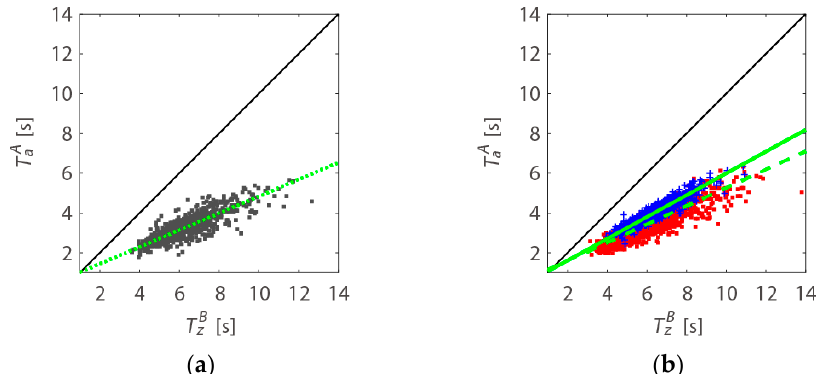
Figure 2. Buoy T B z and altimeter T A a data when the wind speed is lower ( a ) or higher ( b ) than 5 m · s − 1 . In the right-hand panel, the blue (red) plots indicate data for which the wind speed is higher (lower) than 10 m·s − 1 . The regression lines estimated by the orthogonal distance regression (ODR) method are plotted by the dashed (0–5 m·s − 1 ), broken (5–10 m·s − 1 ), and solid (>10 m·s − 1 ) green lines. Table 1. Correlation coefficient (CC), bias, slope of the regression line, and root mean square difference (RMSD) around the regression line for (cid:1846) (cid:3028)(cid:3002) vs. (cid:1846) (cid:3053)(cid:3003) and (cid:1846) (cid:3028)(cid:3002) vs. (cid:1846) (cid:3028)(cid:3003) for various ranges of wind speed. All CC are significant at the 99.9% confidence level.